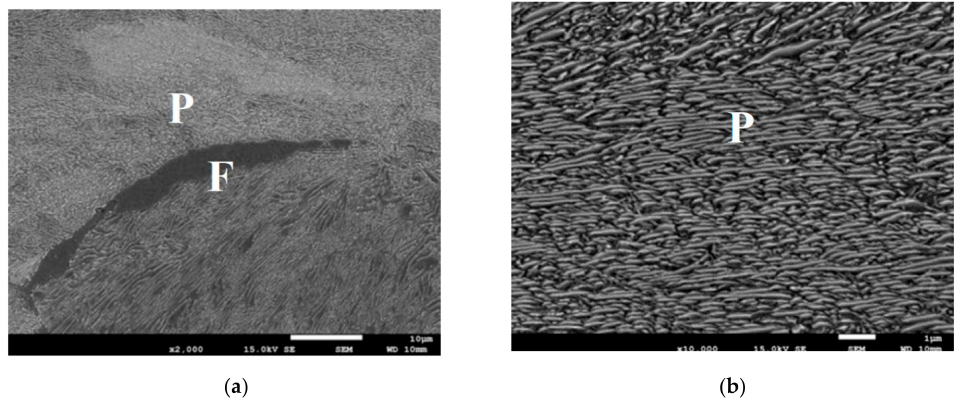
Figure 3. ( a , b ) Selected microstructures of the samples after holding for 1 h at the temperature of 620 ◦ C, various magnifications. P—pearlite;